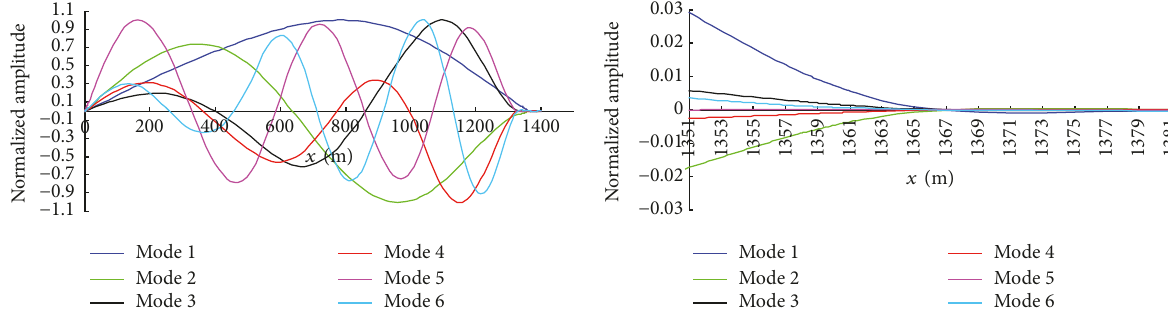
Figure 3: First five natural mode shapes for SBOP riser-conductor.